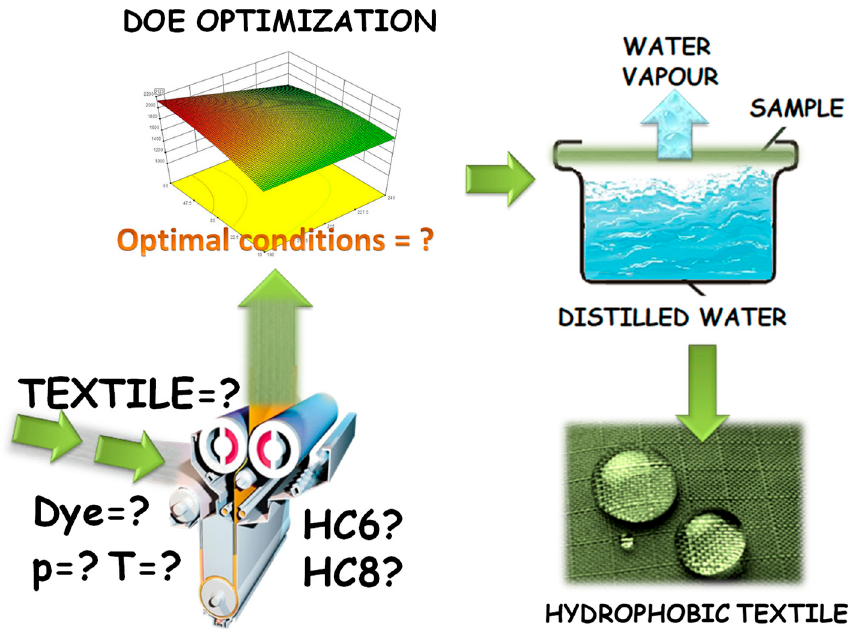
Figure 2. Schematic overview of process for optimizing the highest water vapor permeability by the ASTM E96 method.